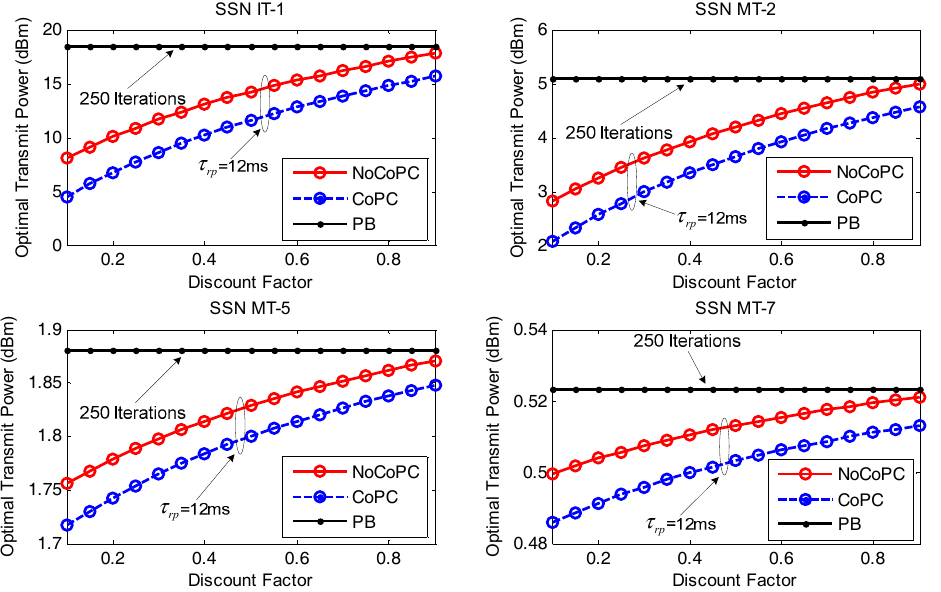
Figure 8. Optimal transmit power vs. discount factor r ( τ rp = 12 ms, l = 250 iterations). NoCoPC: noncooperative power control; CoPC: cooperative power control; PB: power balancing.